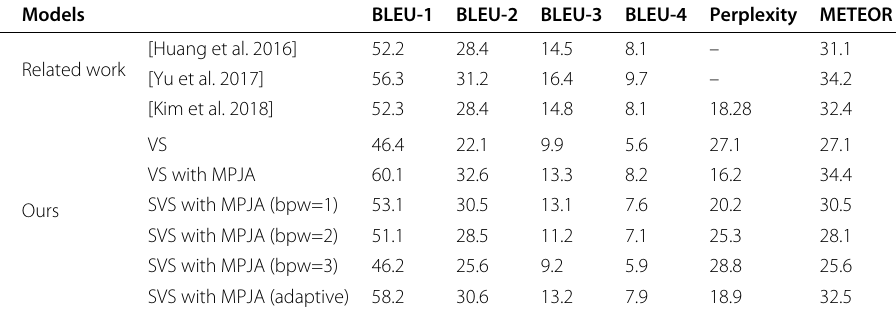
Table 1 Automatic evaluation results on VIST dataset